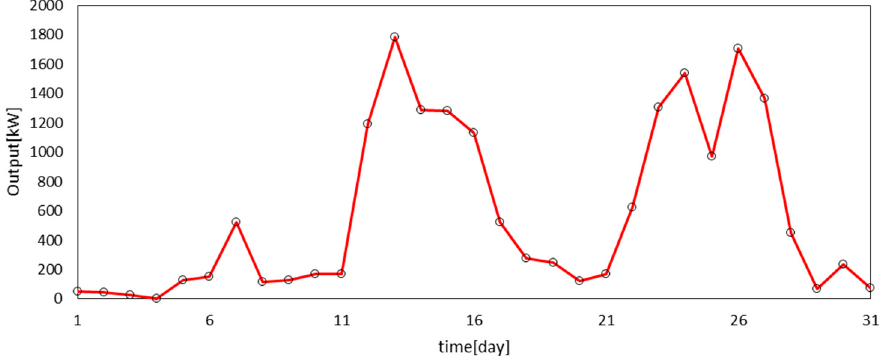
Figure 3. Wind power outputs from Jeju Island in January 2016.